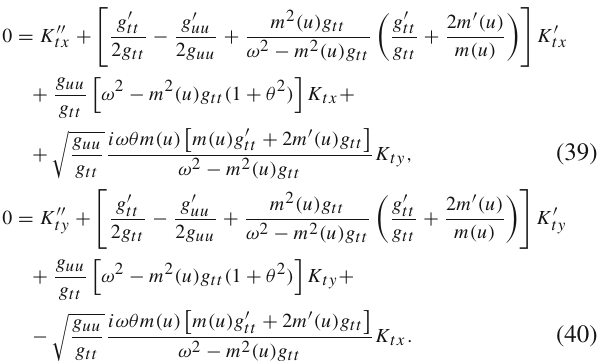
. By substituting ty